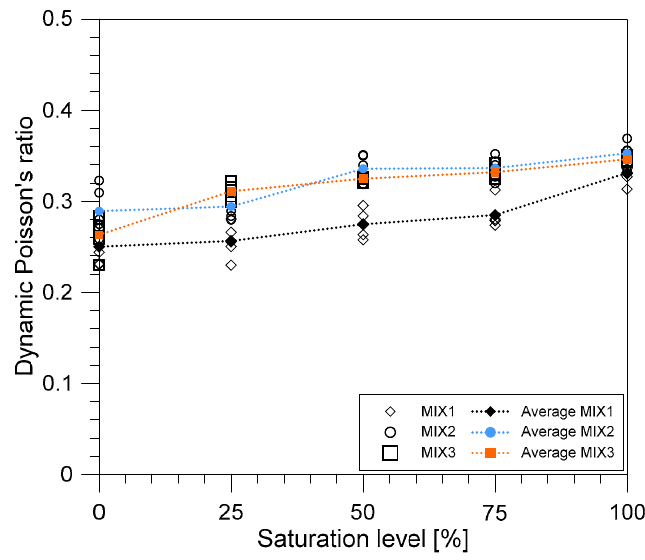
Figure 11. Variation of dynamic Poisson's ratios with the water saturation level of concrete. The variation of dynamic elastic modulus of concrete with an increasing degree of saturation is illustrated in Figure 12. In this research, the dynamic modulus of elasticity was determined using the equation specified in ASTM C215-19 [41] by measuring the fundamental longitudinal resonance frequency ( f L ) as follows,